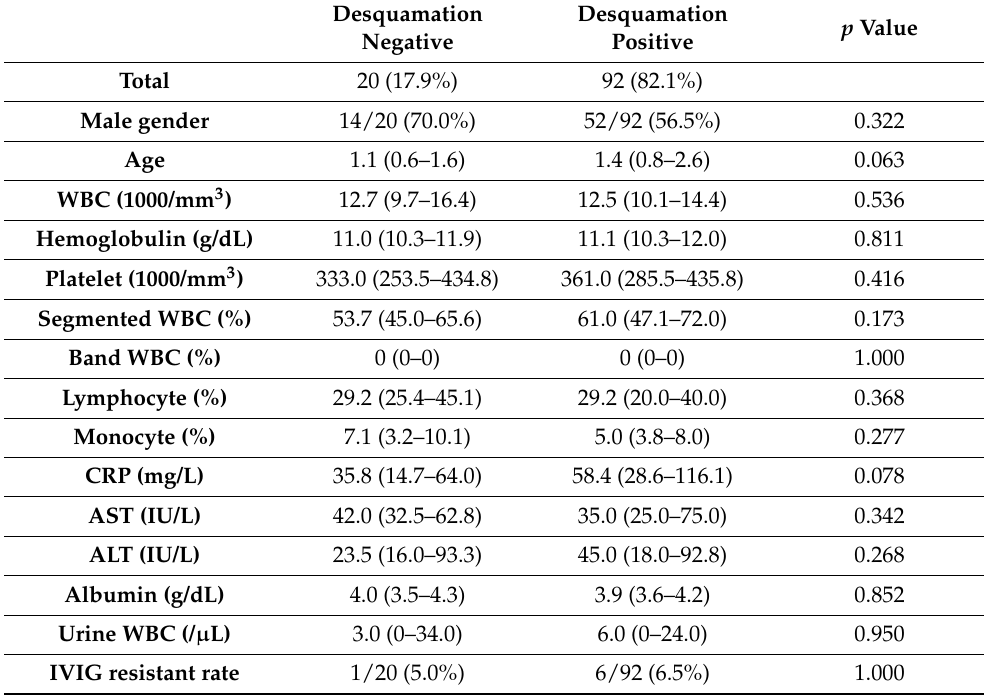
Table 1. Patients’ laboratory data—desquamation positive or negative.